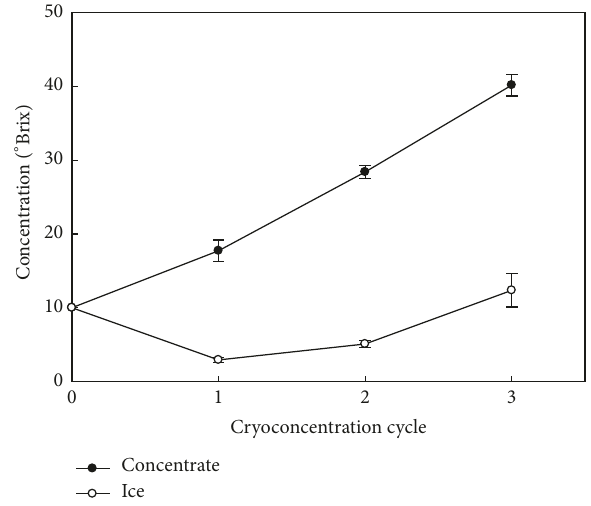
Figure 2: Solute content in the concentrated solution and ice fraction as function of the cryoconcentration cycle for orange juice. (0: fresh juice. 1, 2, and 3: fractions obtained at the first, second, and third cryoconcentration cycles,